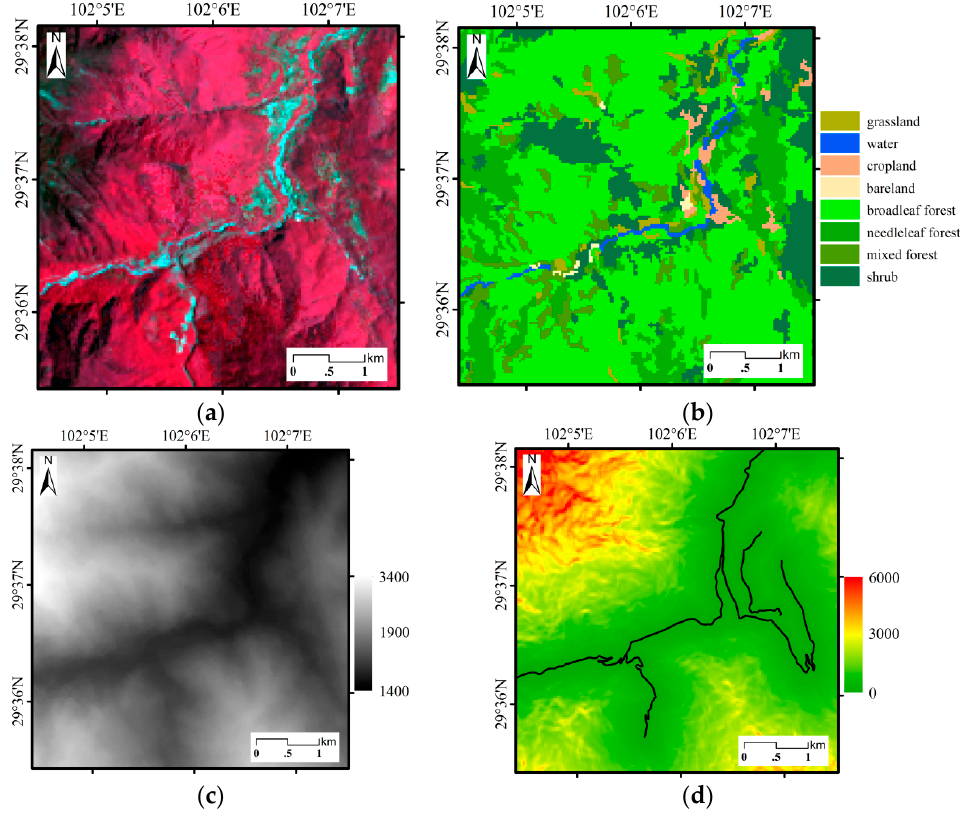
Figure 1. The composite image of Landsat 8 OLI’s 5, 4, and 3 bands (corresponding to R, G, and B color space) ( a ); land cover map ( b ); elevation map ( c ); and cost map ( d ) in the study area. The bold line in ( d ) indicates the roads digitized from Google Earth.